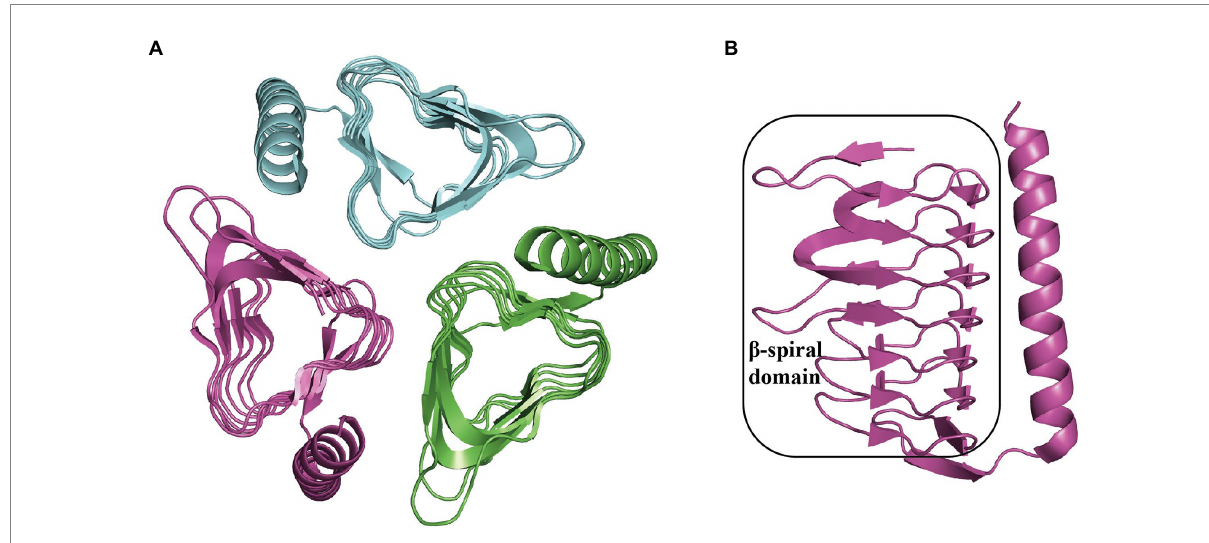
FIGURE 8 Overall structure in PaaY. (A) The overall structure of trimer GkaPaaY (PDB:3VNP) is shown with a different color for each chain. (B) The PaaY consists of a large β -spiral containing one C-terminal α -helix connected by an extra β